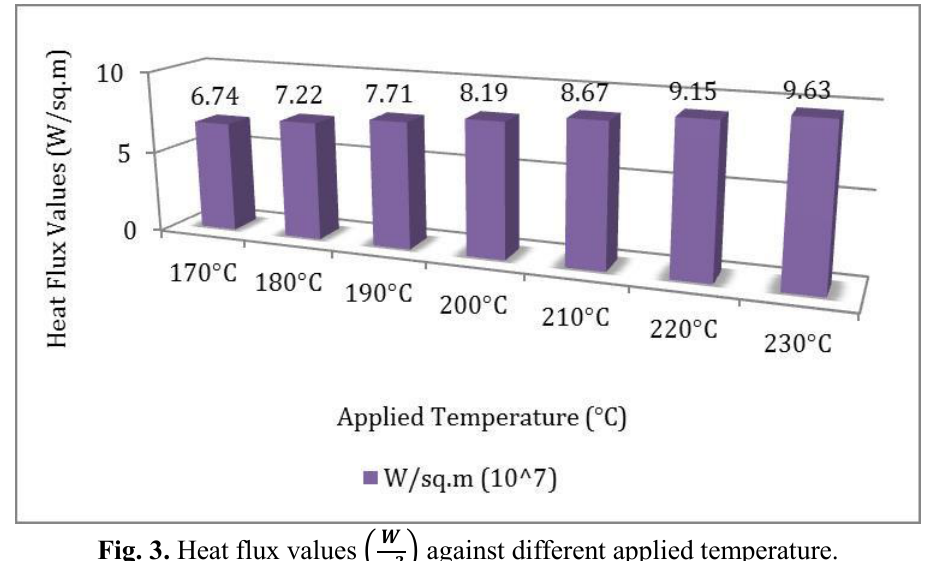
Fig. 3. Heat flux values (